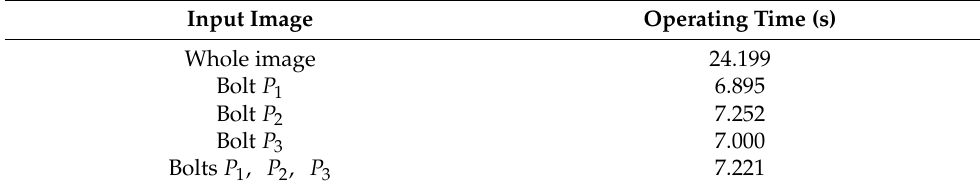
Table 5. Correlation of the GLCM of different vertical displacement amplitudes.